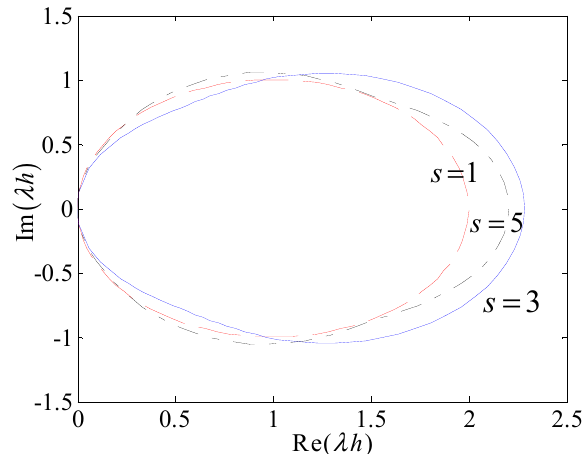
Figure 2. Stability region of new LMF for odd numbers of s.